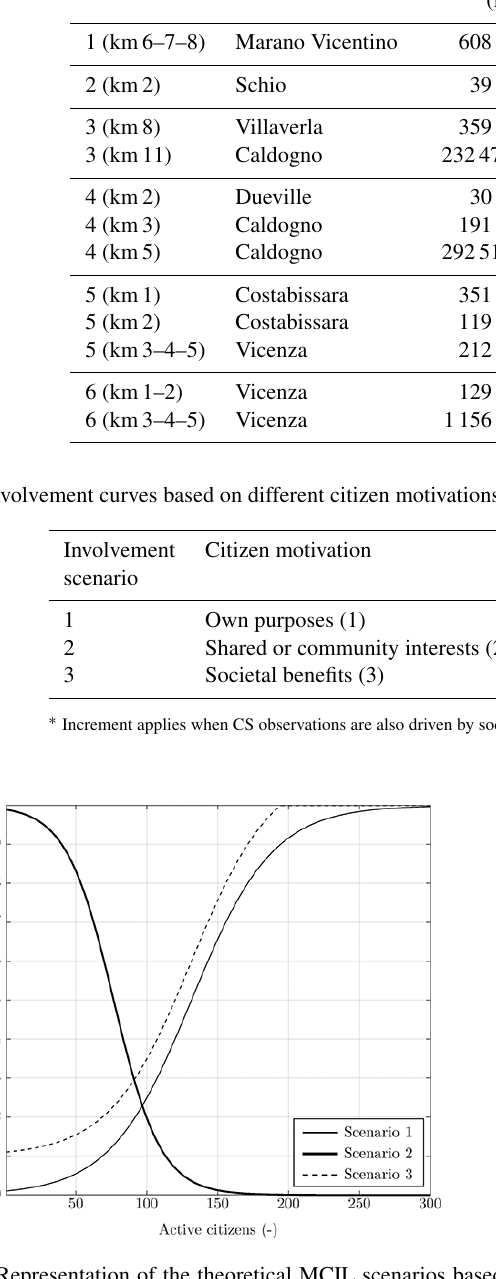
Figure 3. Representation of the theoretical MCIL scenarios based on the number of active